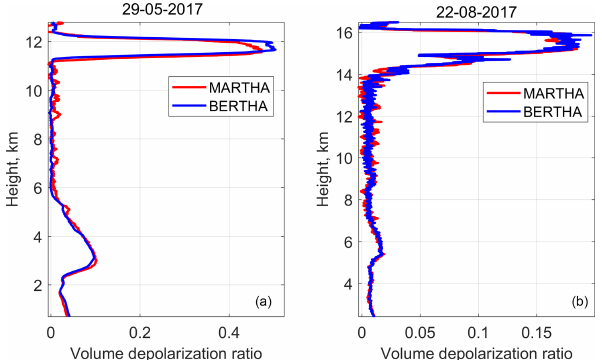
Figure 9. Volume linear depolarization ratio obtained with MARTHA (extended three-signal method) and BERTHA ( (cid:49) 90 ◦ method) on (a) 29 May 2017, 20:20–20:45UTC (with smooth 27 bins) and (b) 22 August 2017, 20:45–23:15UTC (Haarig et al., 2018). The systems were calibrated independently. The systems were located at a distance of 80m.